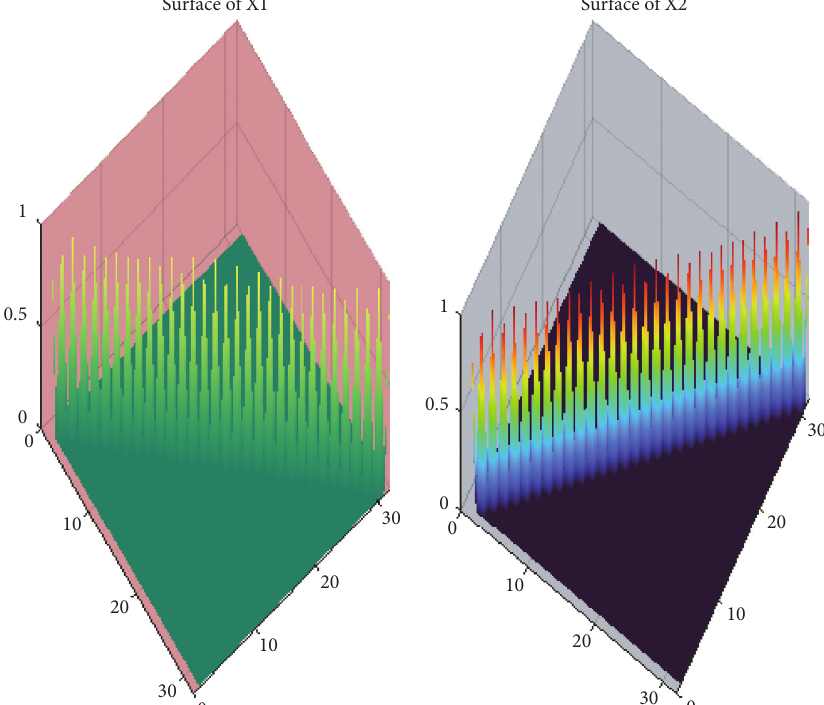
Figure 22: Solution surface plot for dimension 32.